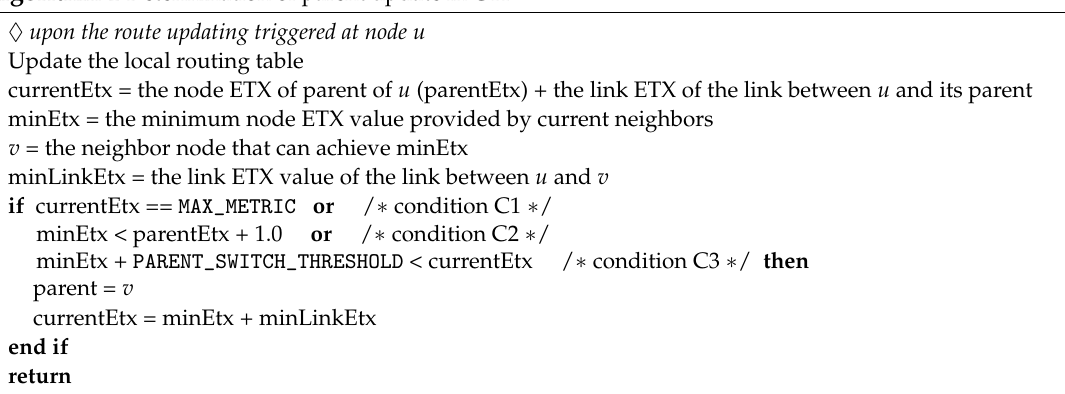
Algorithm 1 Determination of parent update in